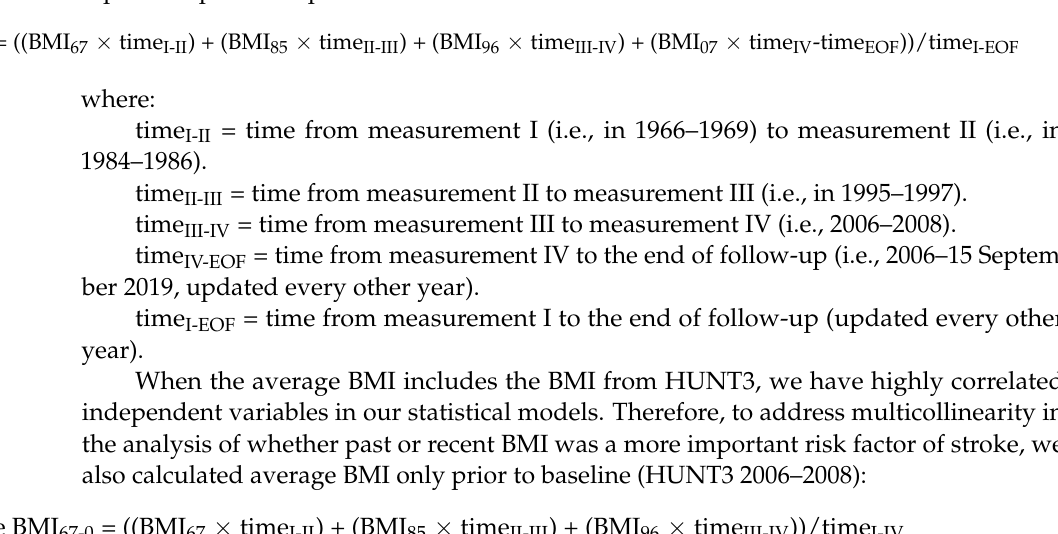
Figure 1. Graphic Presentation of the Study Setup and the Calculation of Average BMI.